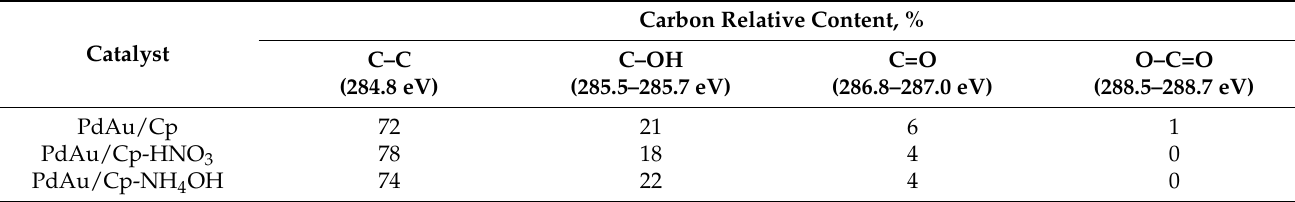
Table 8. Effect of modification of support on contribution of different electronic states of carbon calculated according to XPS.